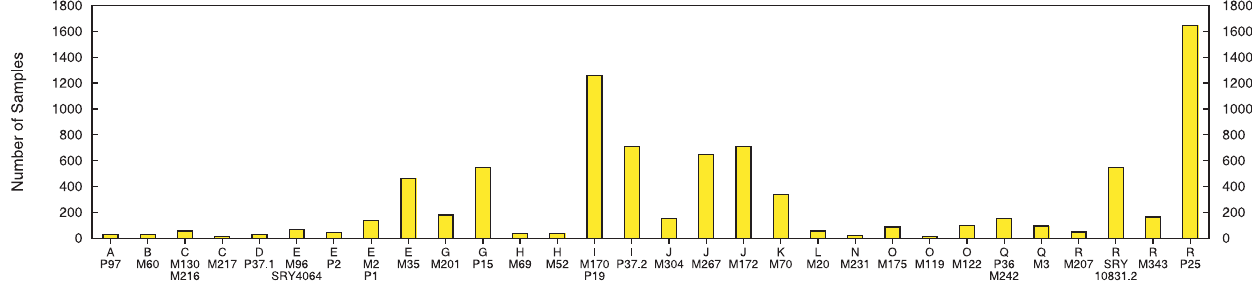
Figure 1. Frequency of 30 haplogroups determined by SNP-typing a geographically diverse sample of 8,414 chromosomes. This set of chromosomes, typed at 15 Y-linked STRs, was used as a ground-truth training set (see text for explanation). Haplogroups are named according to the mutation-based nomenclature [12], which retains the major haplogroup information (i.e., 18 capital letters) followed by the name of the terminal mutation that the sample is positive for (see Figure